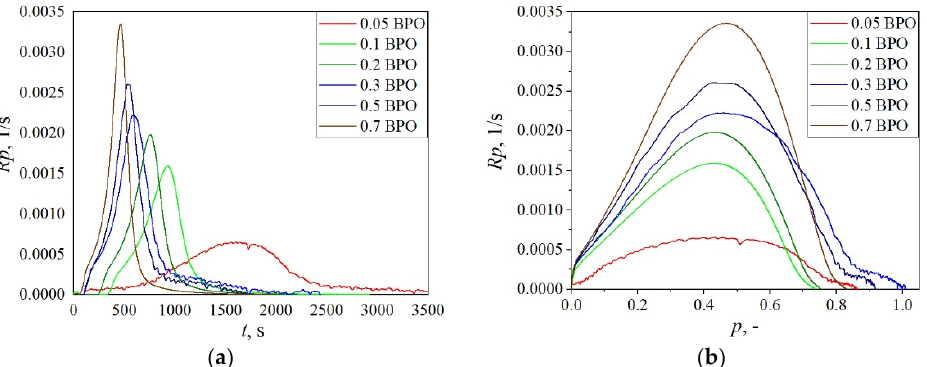
Figure 1. The kinetic curves of the polymerization of bone cement compositions containing various amounts of peroxide BPO and 0.5 wt.% of DMA reductant as a function of polymerization rate ( R p ) from ( a ) reaction time ( t ) and ( b ) double bond conversion ( p ).